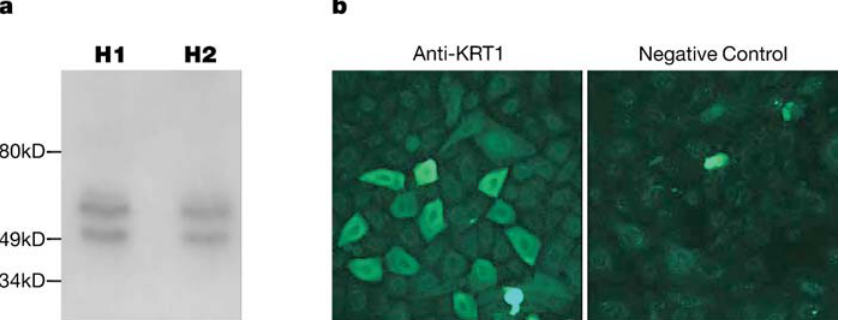
Figure 2. Characterization of KRT1 protein expression in HEK cells. a . Western blot analysis using anti-KRT1 antibody, with the left and right lanes containing proteins isolated from cells homozygous for the KRT1 haplotype patterns H1 (sample 8 in Table 3) and H2 (sample 9 in Table 3) respectively. Replicate gels stained with Coomassie blue demonstrate equal levels of proteins loaded for the HEK samples. All six HEK samples examined contained similar levels of KRT1 protein. b . Immunohistochemistry showing distribution of KRT1 protein in two of the three confluent HEK samples examined. A subset of the anti-KRT1 cells displays strong membrane staining, while the remaining cells display low to moderate level membrane staining. Staining of the nucleus is present at the same level in the anti-KRT1 and negative control cells. All three HEK samples examined display similar KRT1 expression patterns.